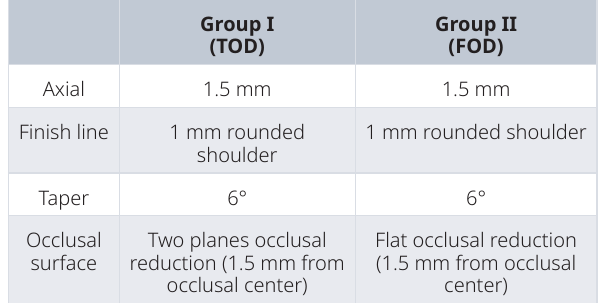
Table 1. Parameters of teeth